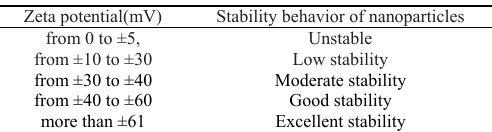
Table 2. Zeta potential values as an indicator of ZVINs stability